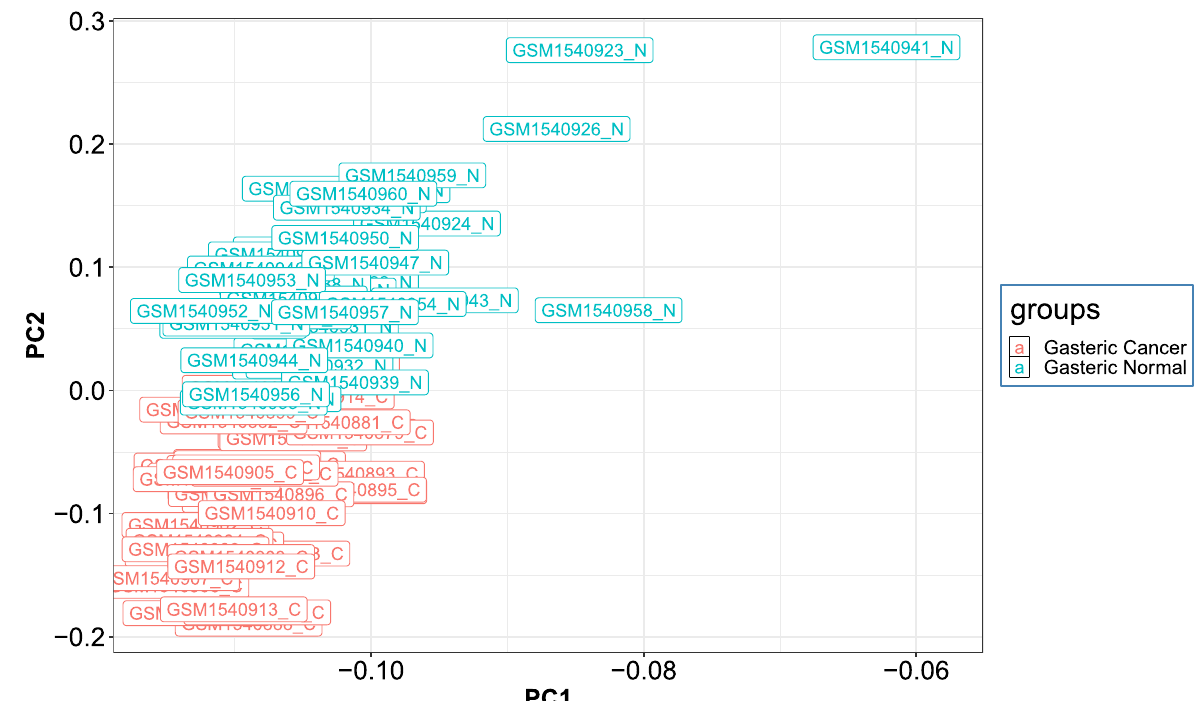
Fig. 1 Illustration of outlier samples in the PCA plot. PC1 is the eigenvector one, and PC2 is the eigenvector two. Normal samples are blue with the suffix N, while tumor samples are red with the suffix C. one of the apparent outlier samples is GSM1540941_N in the top right